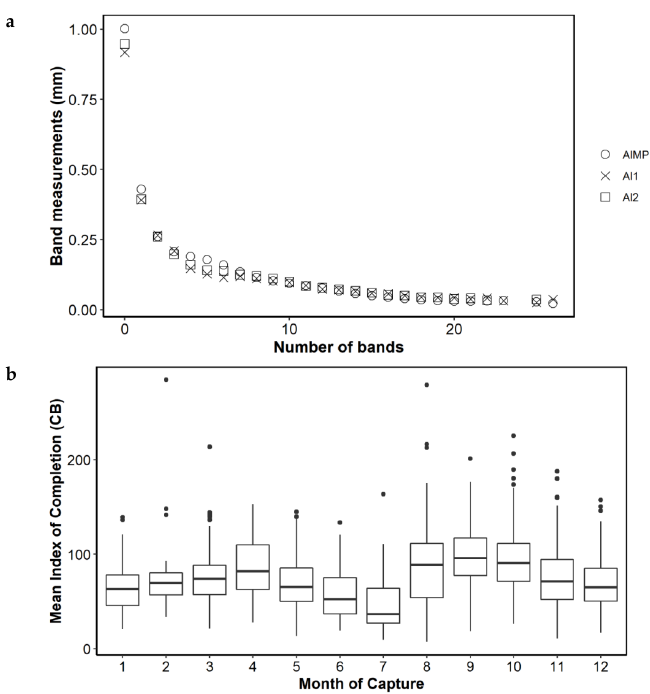
Figure 5. ( a ) plot comparing mean annual band increment measurements from back calculation study (AIMP, [17]), and present study (AI1 = Wn-1 and AI2 = Wn-2). ( b ), mean index of completion (CB) by month.